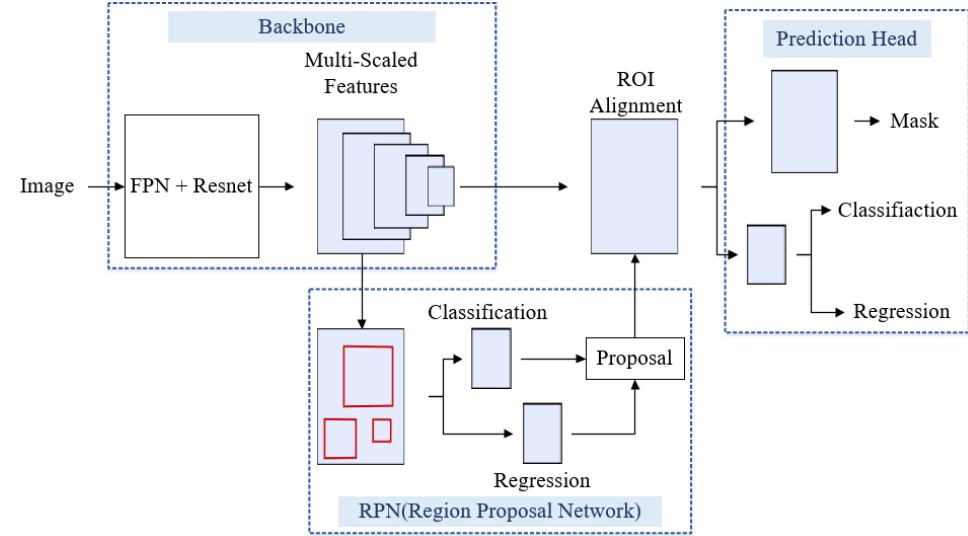
Figure 4. Mask R-CNN architecture.